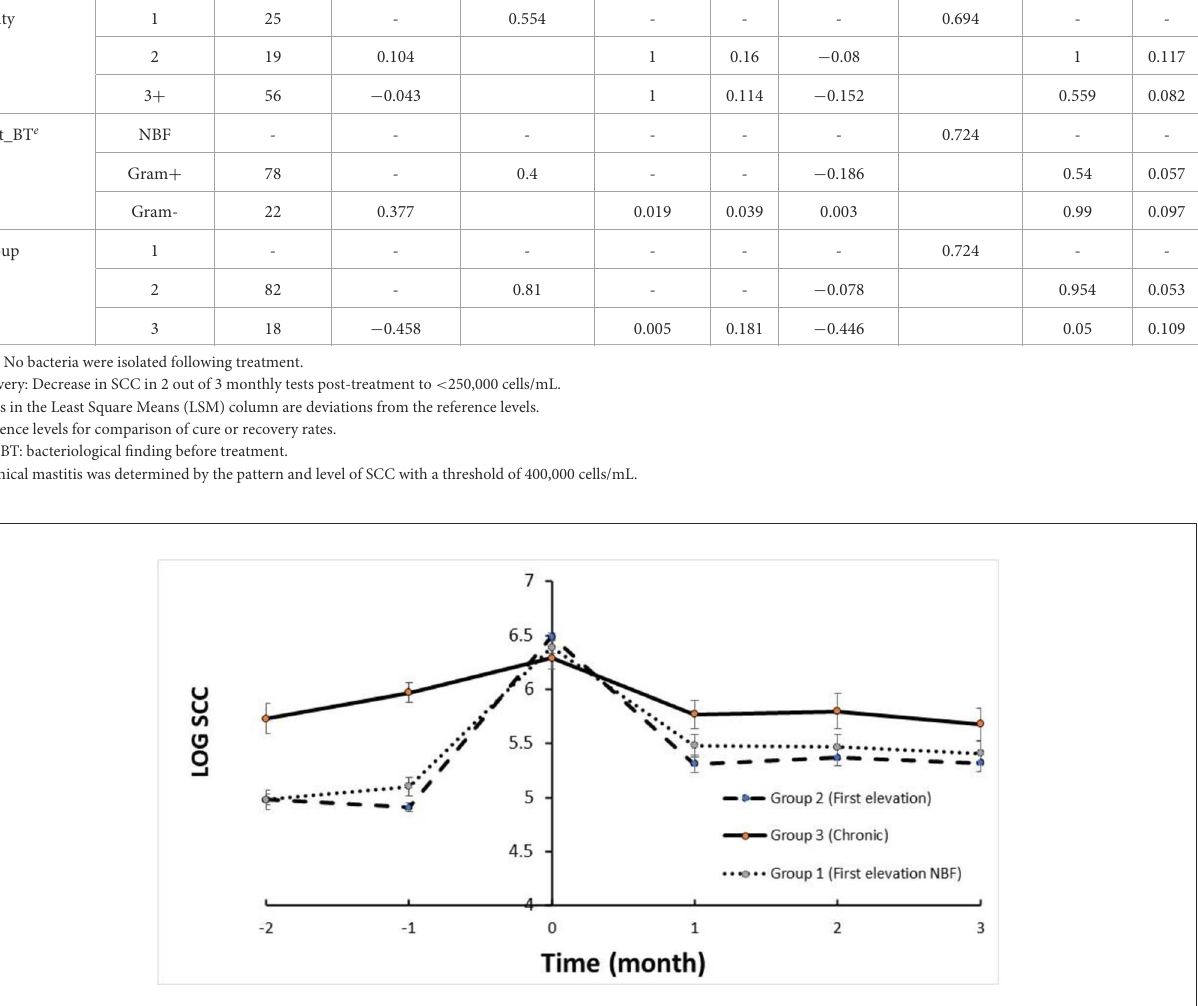
FIGURE1 Mean log of SCC relative to APT treatment according to